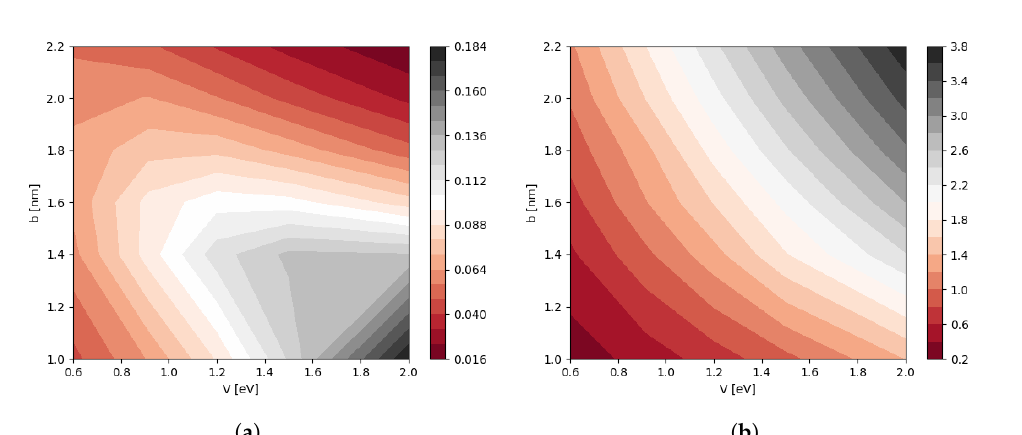
Figure 5. ( a ) The contour of maximum energy gap ∆ max which defined at d = b . ( b ) The contour of fitting exponential parameter α which modeled in Equation (12). The x-axes and y-axes are the potential V and QD base b , respectively.